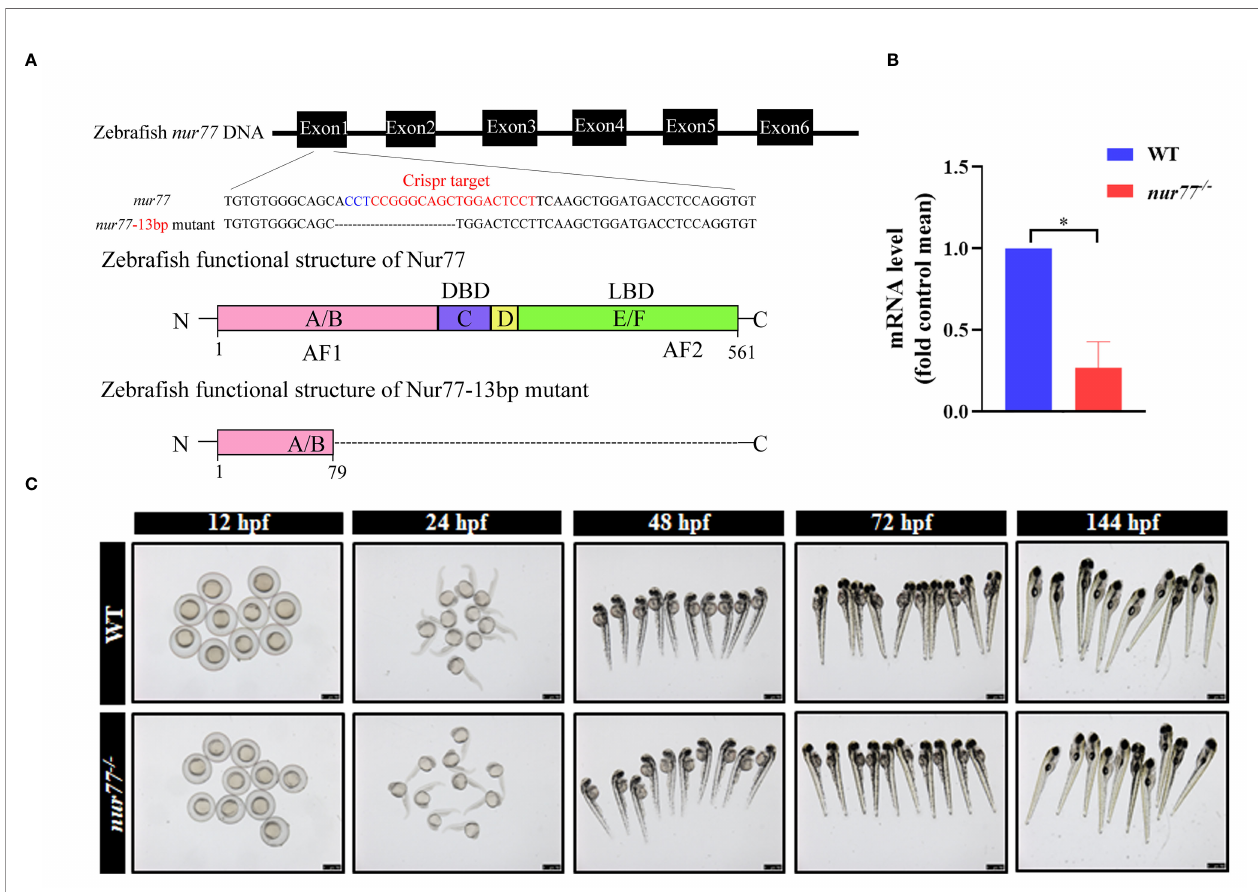
FIGURE 1 | Knockout of nur77 in zebra fi sh by Crispr/Cas9. (A) Schematic representations of Crispr-Cas9 targets and mutant alleles. nur77 consists of 6 exons ( fi lled box). The sgRNA target exon 1, and the sequences of the target region were aligned to the selected allele. The target site was in red font, and the PAM site was in blue font. The obtained nur77 − / − zebra fi sh mutant lacked 13 bp bases, causing protein translation to stop prematurely. (B) The validation of the expression level of nur77 by qRT-PCR analysis ( n = 3); * p < 0.05 by t -test. (C) The morphology of WT and nur77 − / − in developmental stages of 12, 24, 48, 72, and 144 hpf. Scale bars indicate 750 m